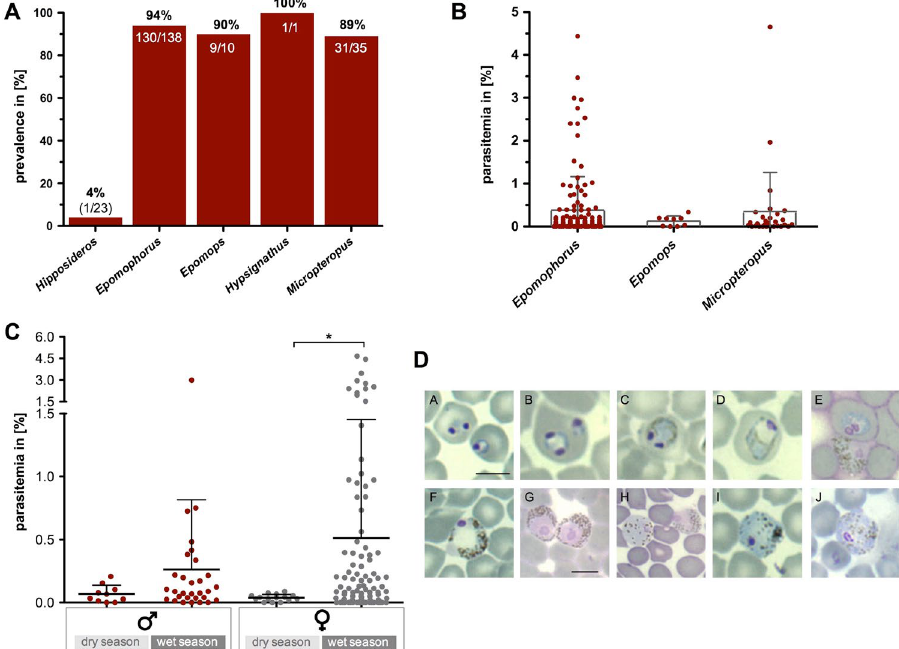
Figure 1. Parasitological parameters of Hepatocystis infections. ( A ) Prevalence of parasite infections in hipposiderid and pteropid host genera in percent (total numbers of infected individuals are listed below). ( B ) Parasitemia levels did not differ significantly between the three host genera Epomophorus , Epomops and Micropteropus (Chi-square = 0.945, df = 2, p = 0.624), suggesting that all three genera are similarly susceptible to Hepatocystis infections. Parasitemia range is given as a percentage, i . e . the number of gametocyte-infected erythrocytes in total erythrocytes and bars indicate mean parasitaemia and standard deviation. ( C ) For both sexes, parasitaemia values were higher in samples from the wet season than from the dry (Table 3), but this difference was only significant for females (females: dry season − n = 15, mean = 0.04% ± 0.03%; wet season − n = 97, mean = 0.51% ± 0.94%; t = − 4.94, df = 97, p < 0.0005; males: dry season − n = 10, mean = 0.07% ± 0.07%; wet season − n = 30, mean = 0.26% ± 0.55%; t = − 1.10, df = 38, p = 0.278). ( D ) Representative micrographs showing gametocyte stages of Hepatocystis parasites of Epomophorus hosts. A–E depict early gametocyte stages, F , G depict mature male microgametocytes, I , J depict mature female macrogametocytes and H depicts a macro- (left) and microgametocyte (right). Bar indicates 5 µ